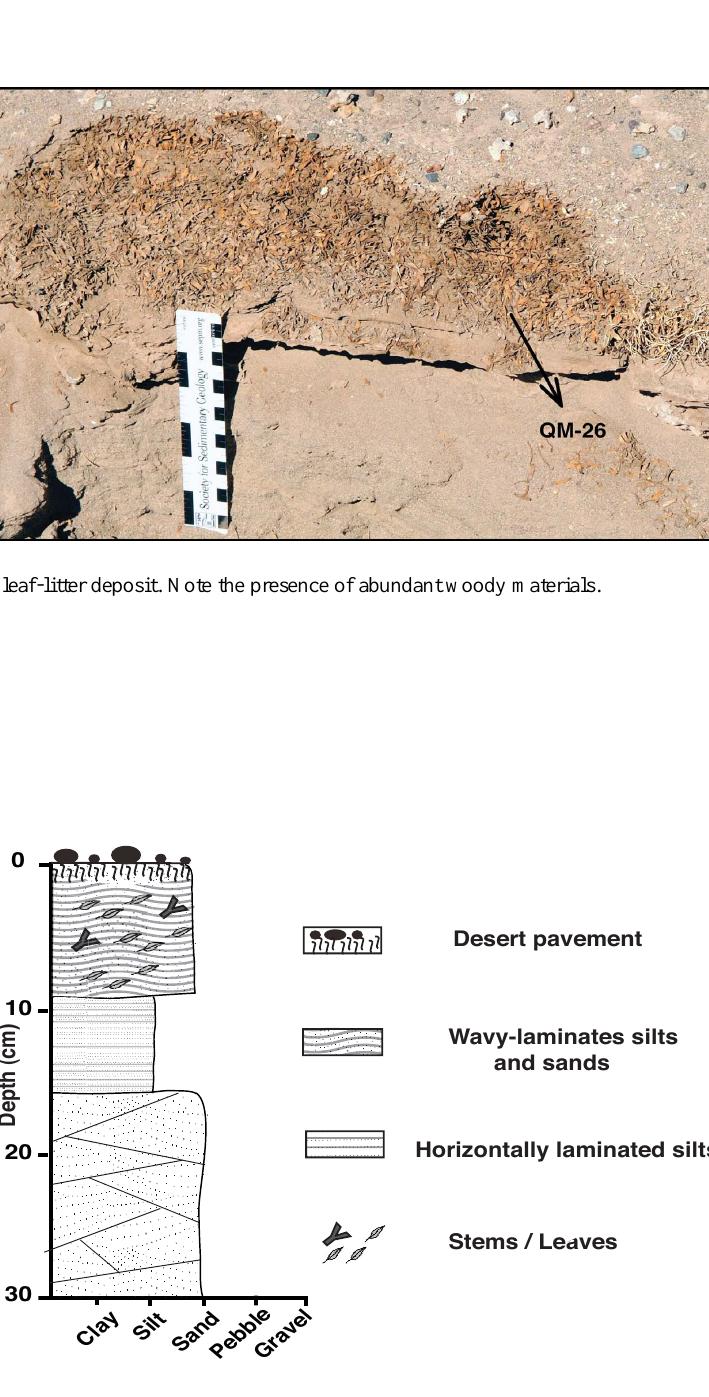
Fig. A2. Stratigraphic section for QM-26 subsurface deposit of situ